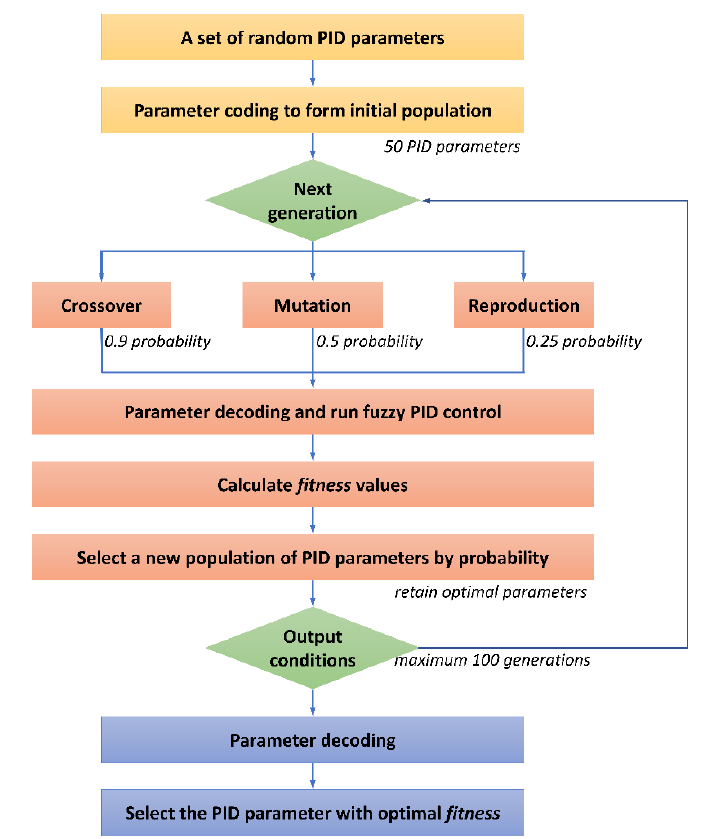
Figure 7. Genetic algorithm optimization process for PID control parameters.